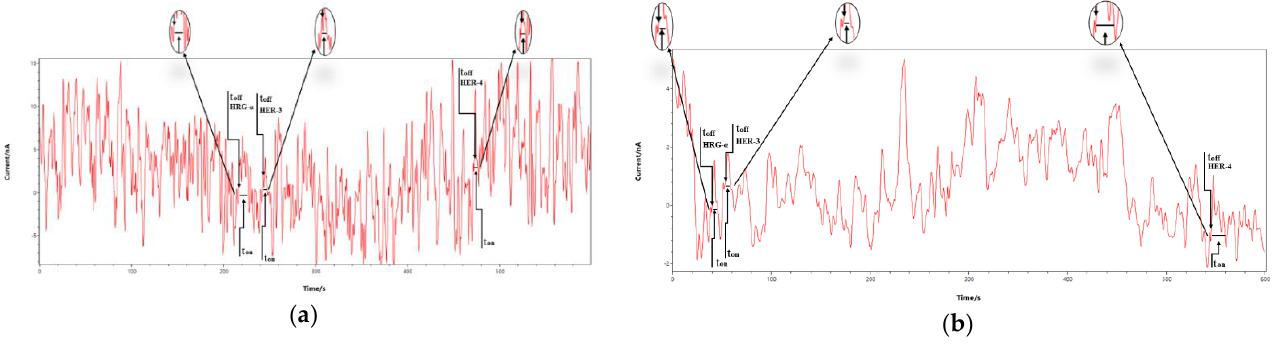
Figure 2. Pattern recognition of HRG − α , HER − 3 and HER − 4 in tissue samples using stochastic sensors: ( a ) MD/Gr − TiO 2 , ( b ) MD/Gr − TiO 2 − Au.